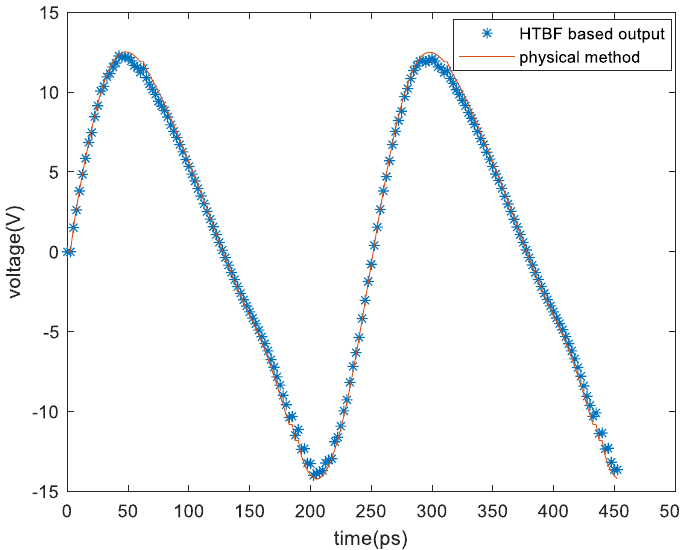
Figure 9. Comparison between the PIN diode voltage calculated by the HTBF method and the physical model method.